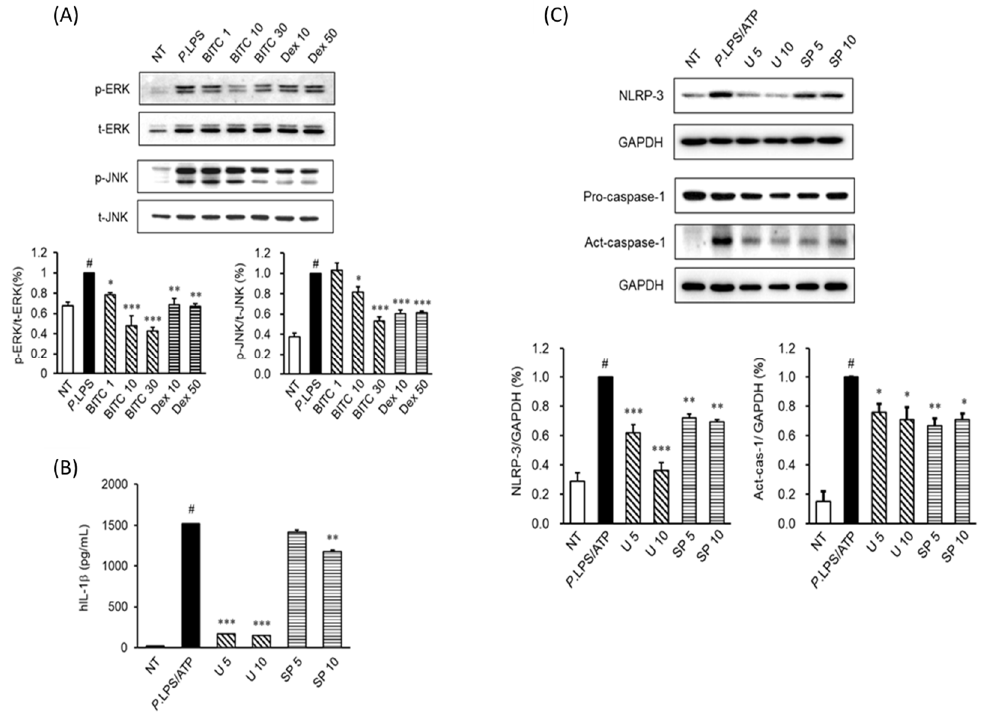
Figure 3. The effects of BITC on inflammasome activation in P. aeruginosa LPS-stimulated THP-1 cells. The cells were seeded at 1 × 10 6 cells/mL and incubated with various BITC concentrations (1, 10, and 30 μ M) for 1 h prior to P. aeruginosa LPS stimulation (10 μ g/mL). ( A ) After treatment with P. aeruginosa LPS for 15 min and 30 min, the phosphorylated forms of ERK and JNK were determined using western blotting, respectively. ( B ) After stimulation with P. aeruginosa LPS/ATP for 24 h in the presence or absence of U 0126 and SP 600126 for 1 h, IL-1 β production by THP-1 cells was determined via ELISA. ( C ) After treatment with LPS/ATP in the presence or absence of U 0126 (5 and 10 µ M) and SP 600126 (5 and 10 µ M) for 1 h, NLRP3 and caspase-1 protein expression were determined using western blotting. GAPDH was used as an internal control for the western blot analyses. Each value indicates the mean ± SD and is representative of results obtained from three independent experiments. # p < 0.05 vs. untreated group; * p < 0.05, ** p < 0.01 and *** p < 0.001 vs. P. aeruginosa LPS group. NT, untreated group; U, U 0126; SP, SP